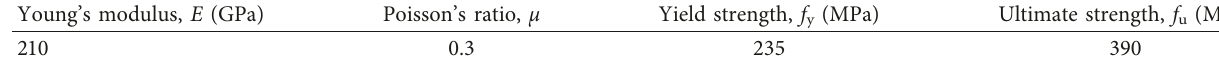
Table 1: Material properties of specimens.